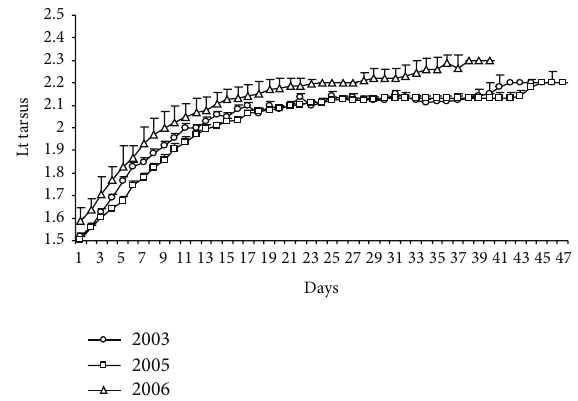
Figure 9: Daily increment in the growth (cm) of the beak of Sterna hirundinacea.